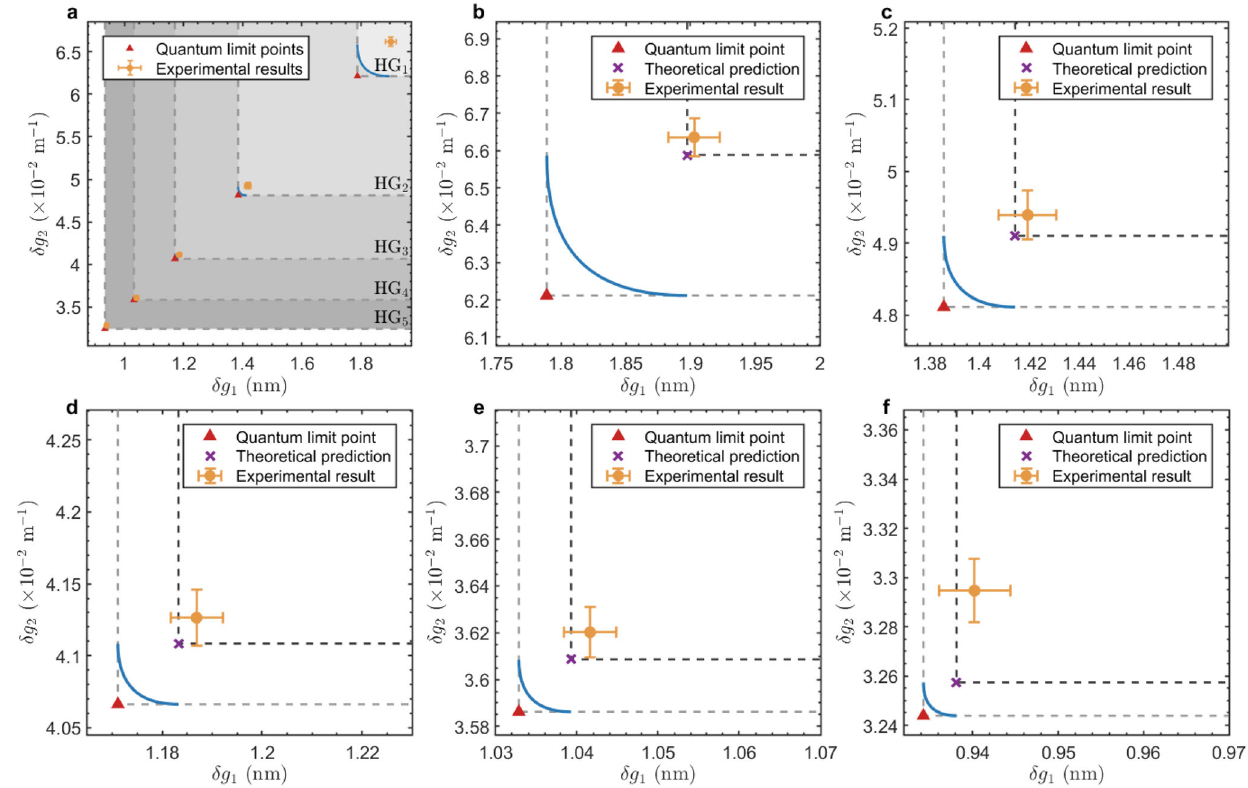
Fig. 6 | Experimental results ofminimum detectable parameters g 1 and g 2 . The experimental results are illustrated by the yellow points with error bar. The trade- offboundsofparameters g 1 and g 2 withdifferentHGmodesarerepresentedbythe blue solid curves. a Experimental results of HG 1 to HG 5 modes. The different HG regions are distinguished by the gray levels. The gray dashed lines are the QCR boundsofparameters g 1 and g 2 withdifferentHGmodes,andthecrosspoints(red